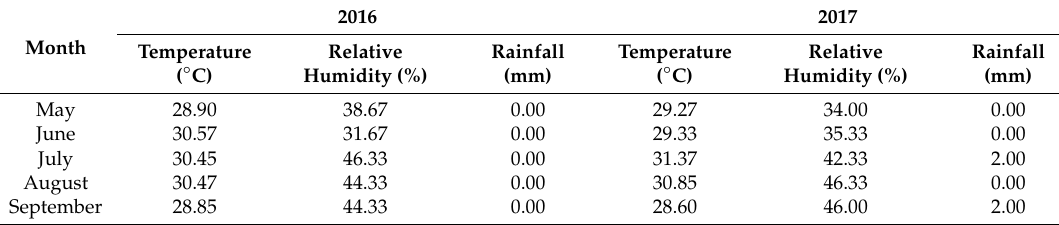
Table 1. Average temperature and relative humidity in the study area in Giza, Egypt, during the summer seasons of 2016 and 2017. Data obtained from the Central Laboratory for Agricultural Climate (CLAC), Agricultural Research Center (ARC),